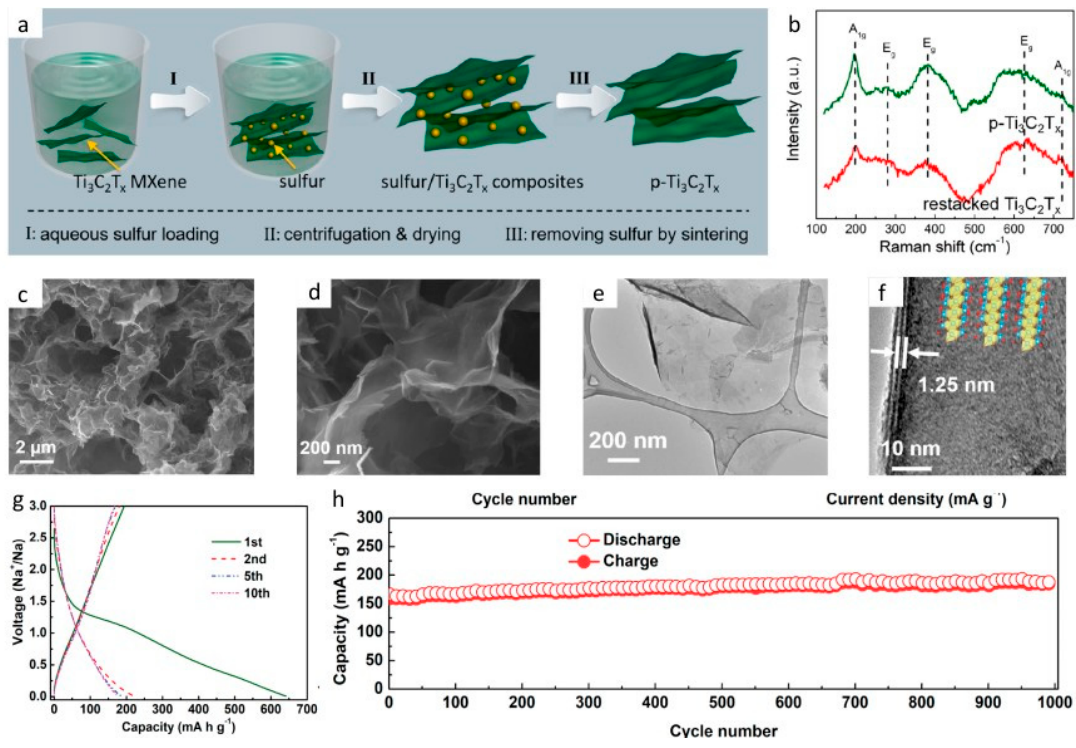
Figure 9. Structural characterization and electrochemical performance analysis of p-Ti 3 C 2 T x as an